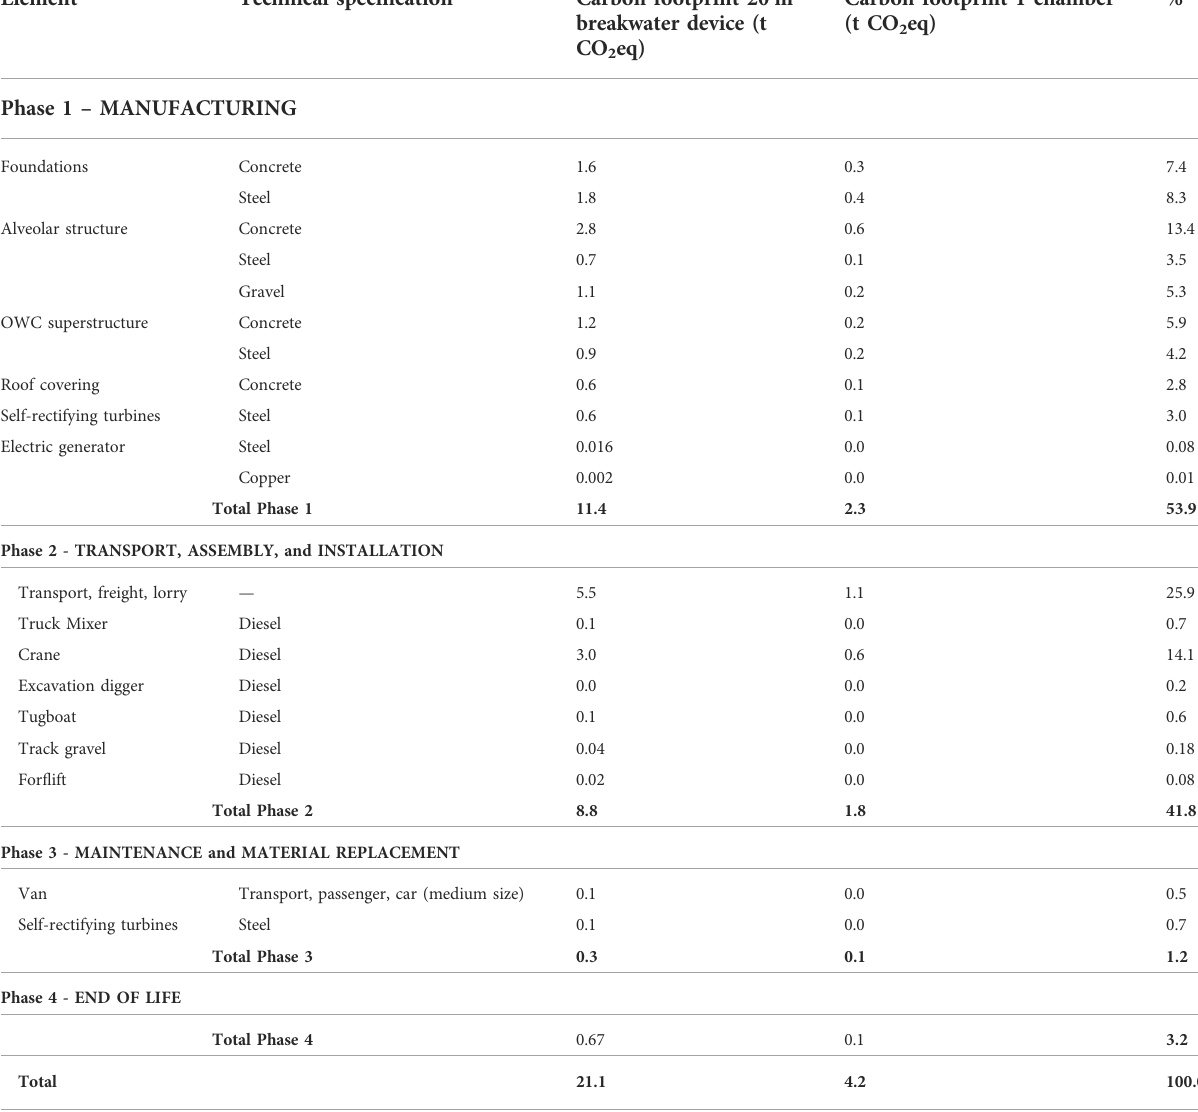
TABLE 5 Total GWP (t CO 2 eq) impact category results for the OWC system and values for individual components. Values in bold represent totals and